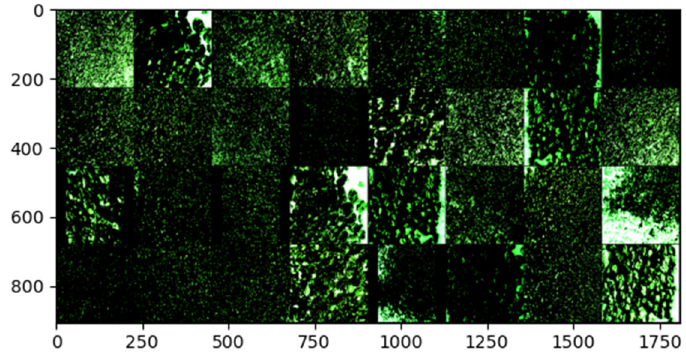
Figure 4. Image of a batch after data enhancement.